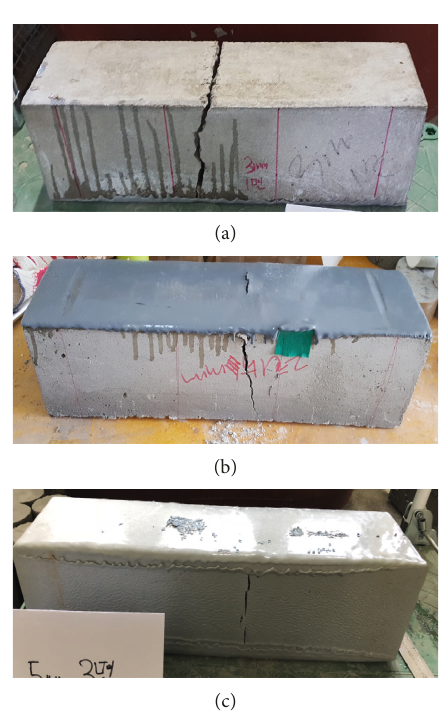
Figure 5: Failure modes of U-series specimens of (a) U31, (b) U51, and (c)